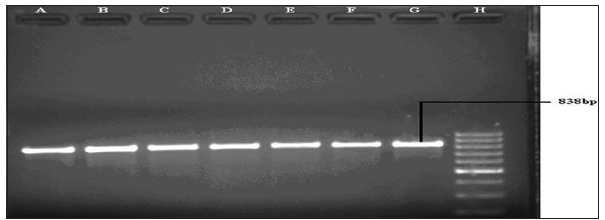
Figure-3: Polymerase chain reaction for the detection of oma87 gene (838 bp) of Pasteurella multocida . Lane A to G: Samples positive for oma87 gene. Lane H: 100bp DNA